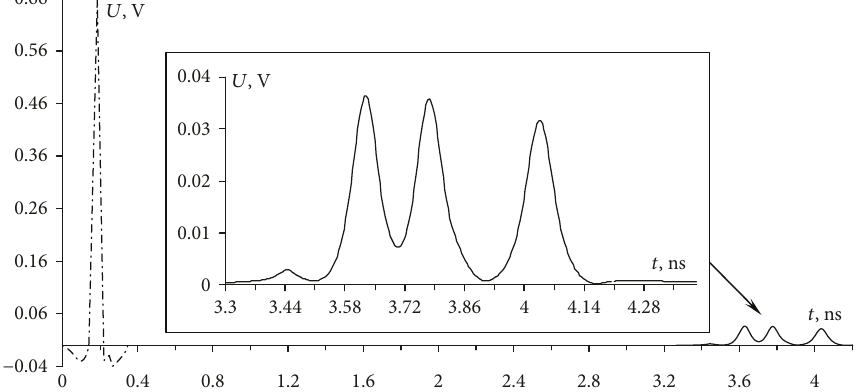
Figure 7: Voltage waveforms at the input ( – · – ) and output ( — ) (with enlarged fragment of the signal at the output) of a three-conductor microstrip line MF after optimization of parameter s Table 6: Results of the GA optimization of s MF output.